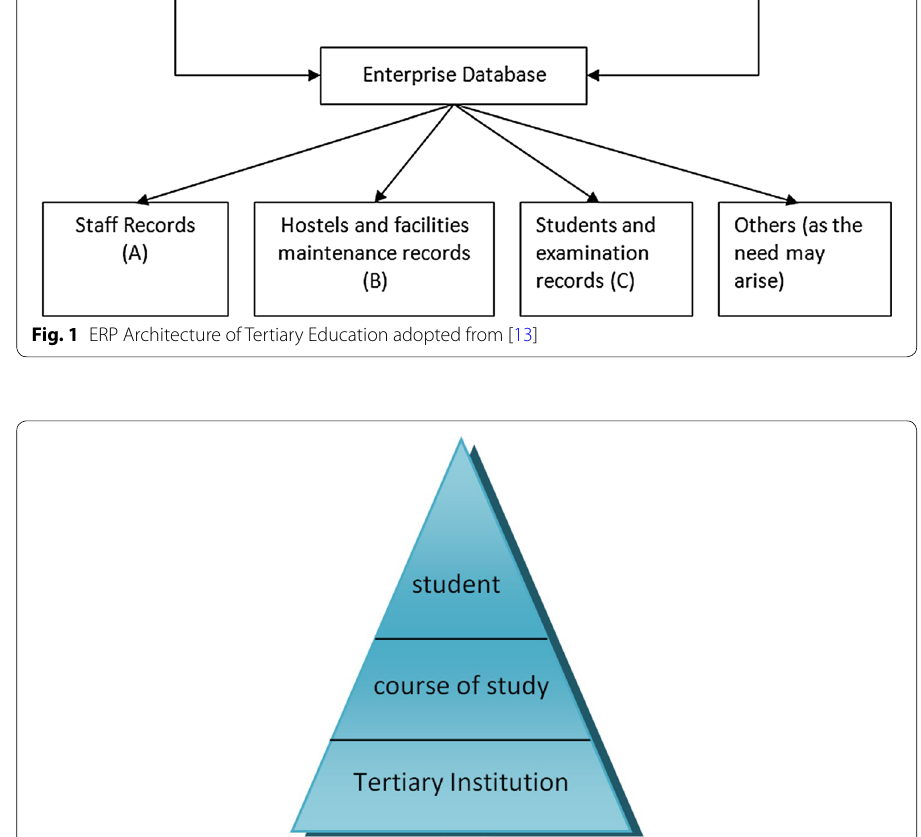
Fig. 2 ERP-Based Data Model of Tertiary